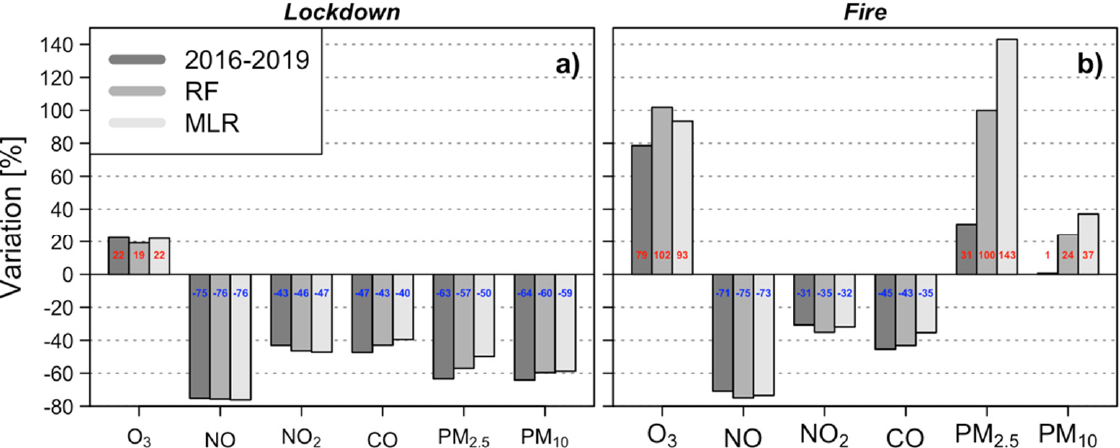
Figure 6. Mean percent variations for the ( a ) Lockdown and ( b ) Fire periods with respect to the reference and the MLR and RF models.